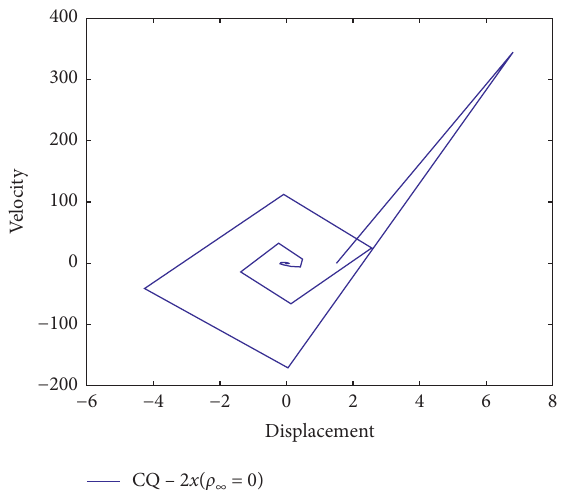
Figure 26: Phase portrait of the hardening spring calculated using CQ-2 x ( ρ